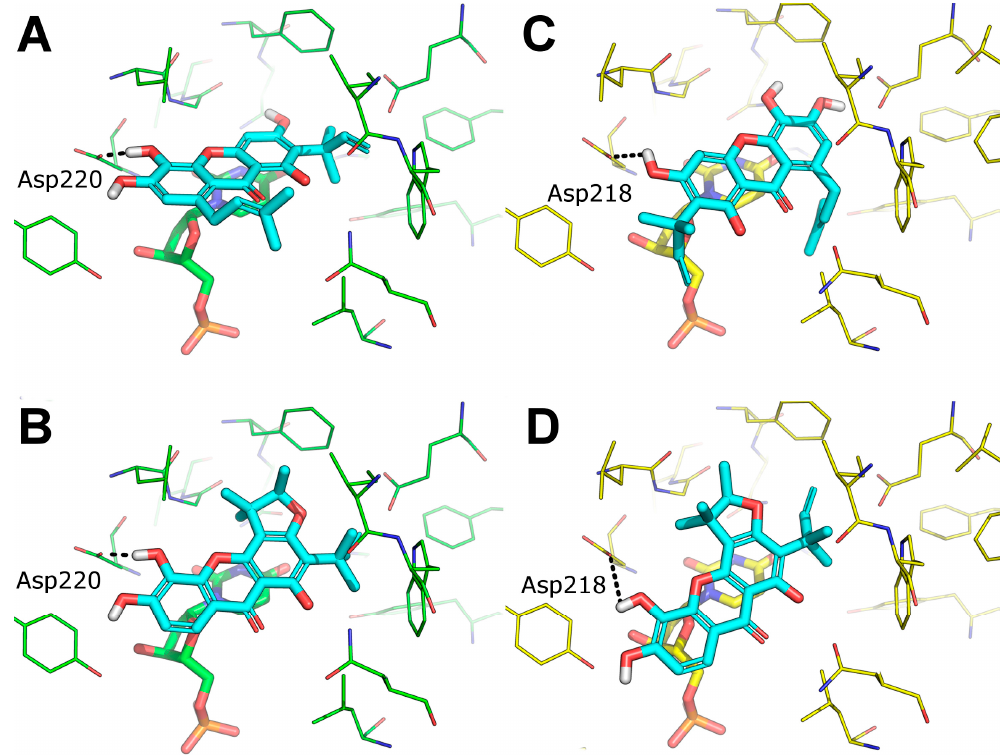
Figure 5. Predicted binding mode of alvaxanthone and rheediaxanthone against TS. ( A , B ) docking pose of alvaxanthone ( A ) and rheediaxanthone ( B ) against the catalytic site of TS from C. elegans, PDB ID 4IQQ (green lines). ( C , D ) docking pose of alvaxanthone ( C ) and rheediaxanthone ( D ) against the catalytic site of TS from homo sapiens PDB ID 5X5D (yellow lines). TS inhibitors are shown as cyan lines. dUMP is shown as sticks and colored as the protein. H-bonds are showed as black dashed lines. Only residues within 5 Å from the docked ligands are shown.